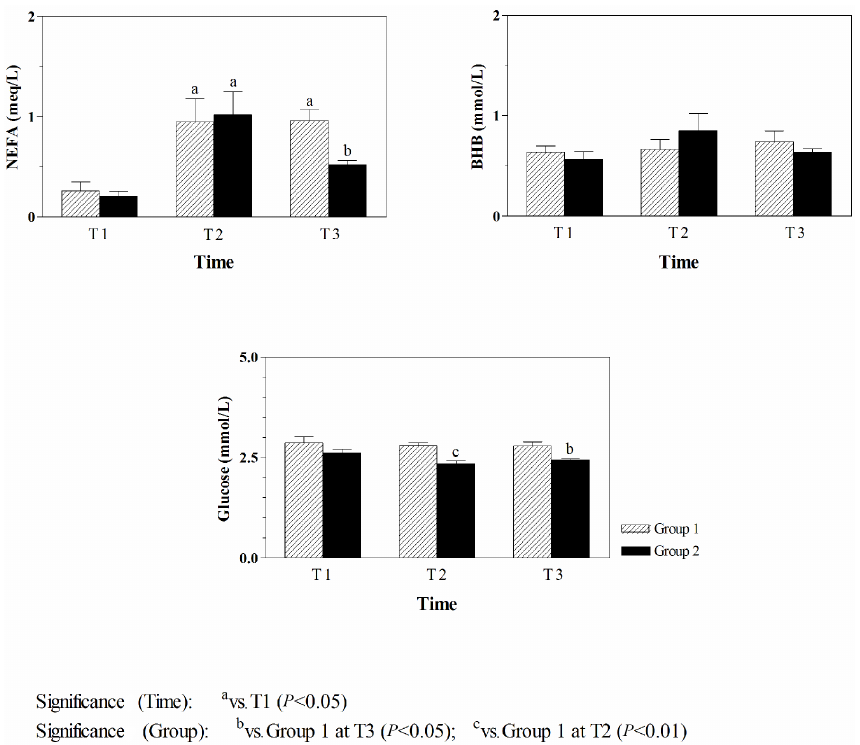
Figure 2. Pattern of glucose, BHB, and NEFA in Group 1 and Group 2 dairy cows monitored at 1 week before the expected partum (T1), and at 1 week (T2) and 2 weeks (T3)